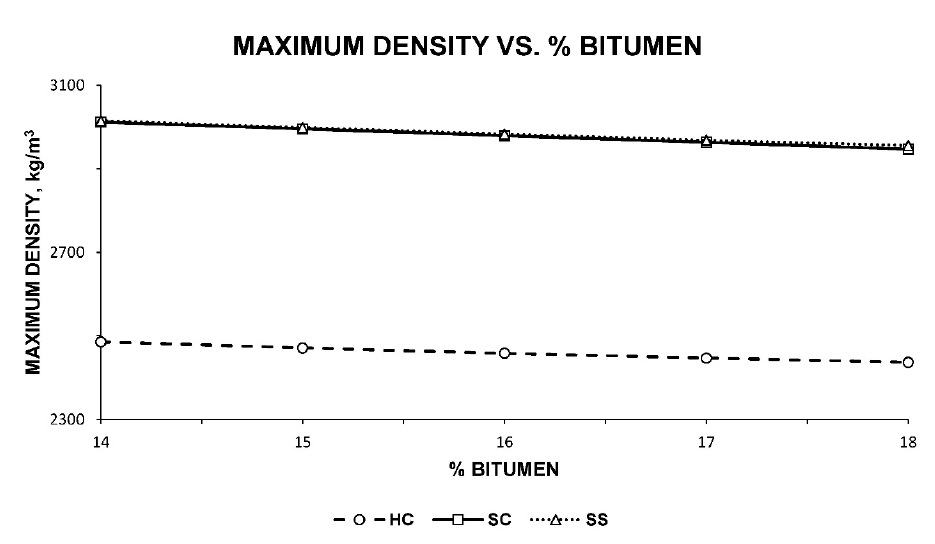
Figure 7. Maximum density of the HC, SC, and SS families of bituminous mixtures according to the percentage of bitumen. On the other side, the determination of the void content in the mix from the maxi ‐ mum density and the bulk density is essential. The void content is reflected in Figure 8 for all families of bituminous mixtures.